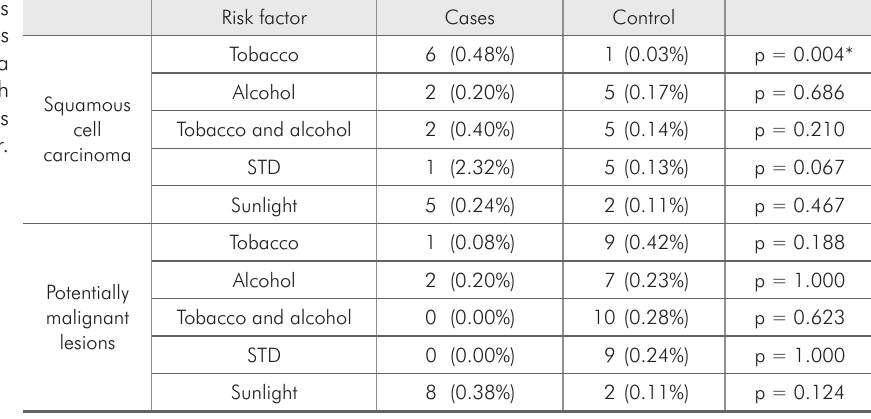
Table 3 - Exposure of patients with potentially malignant lesions and squamous cell carcinoma diagnosed by secondary health care personnel to the risk factors for oral